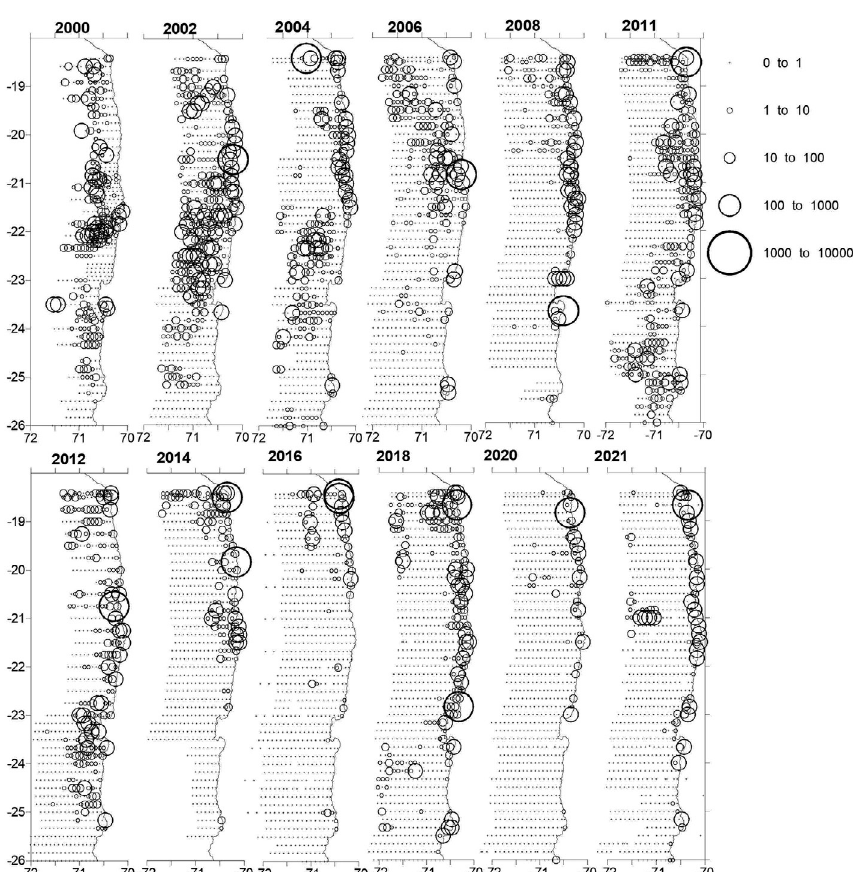
Fig. 1. – Anchovy egg distribution from 2000 to 2021. Diameter of the circles are proportional to the eggs numbers (N°/0.05 m 2 ). Circles in eggs number/0.05 m 2 .